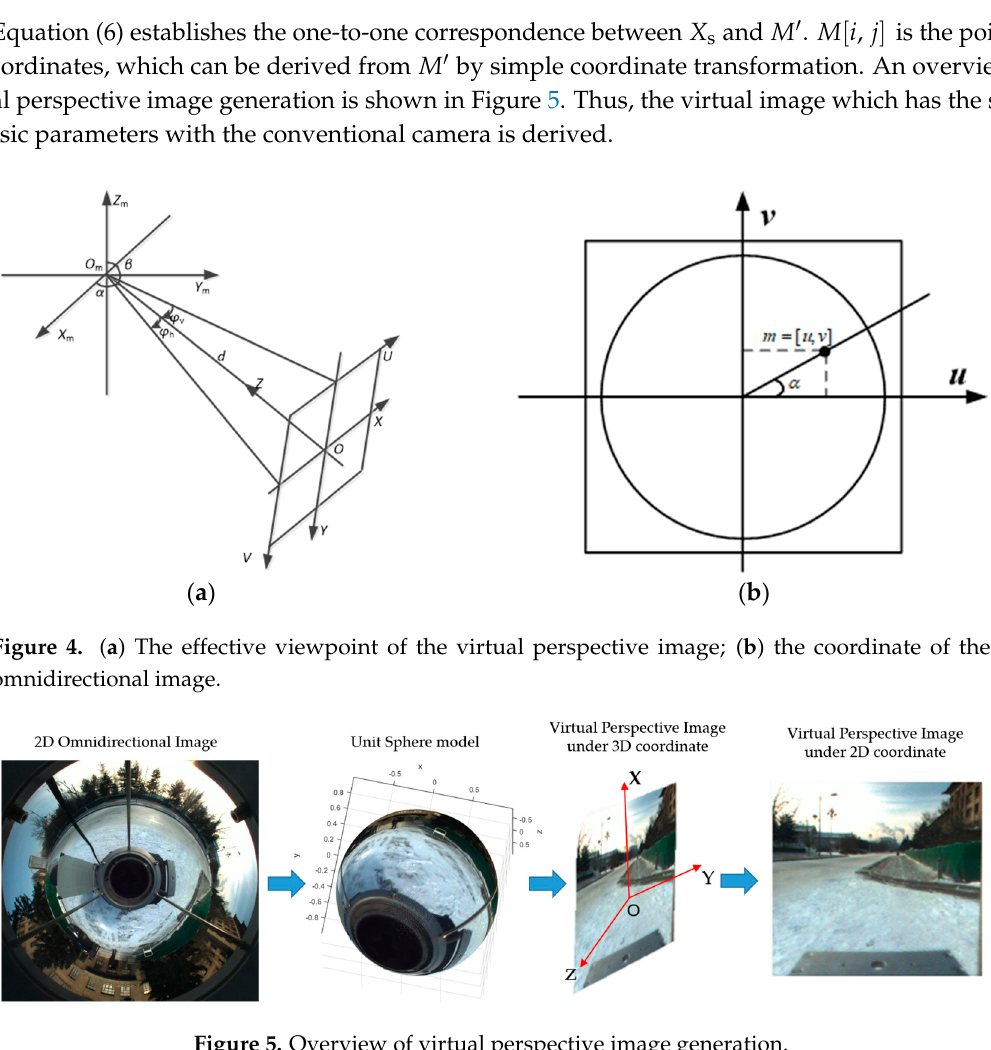
Figure 5. Overview of virtual perspective image generation.